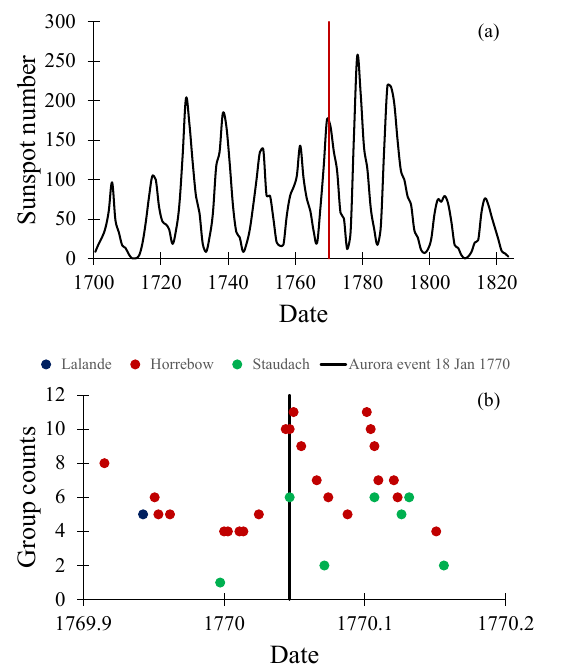
Figure 4. (a) Yearly sunspot number from 1700 to 1825. (b) Sunspot group counts from 1 December 1769 to 28 Febru- ary 1770. Blue, red, and green dots depict the sunspot observations made by Lalande, Horrebow, and Staudach, respectively. The ver- tical red and black lines represent the date of occurrence (18 Jan- uary 1770) of the aurora event studied in the present work. Note that dates are in decimal numbers, not in “year-month”